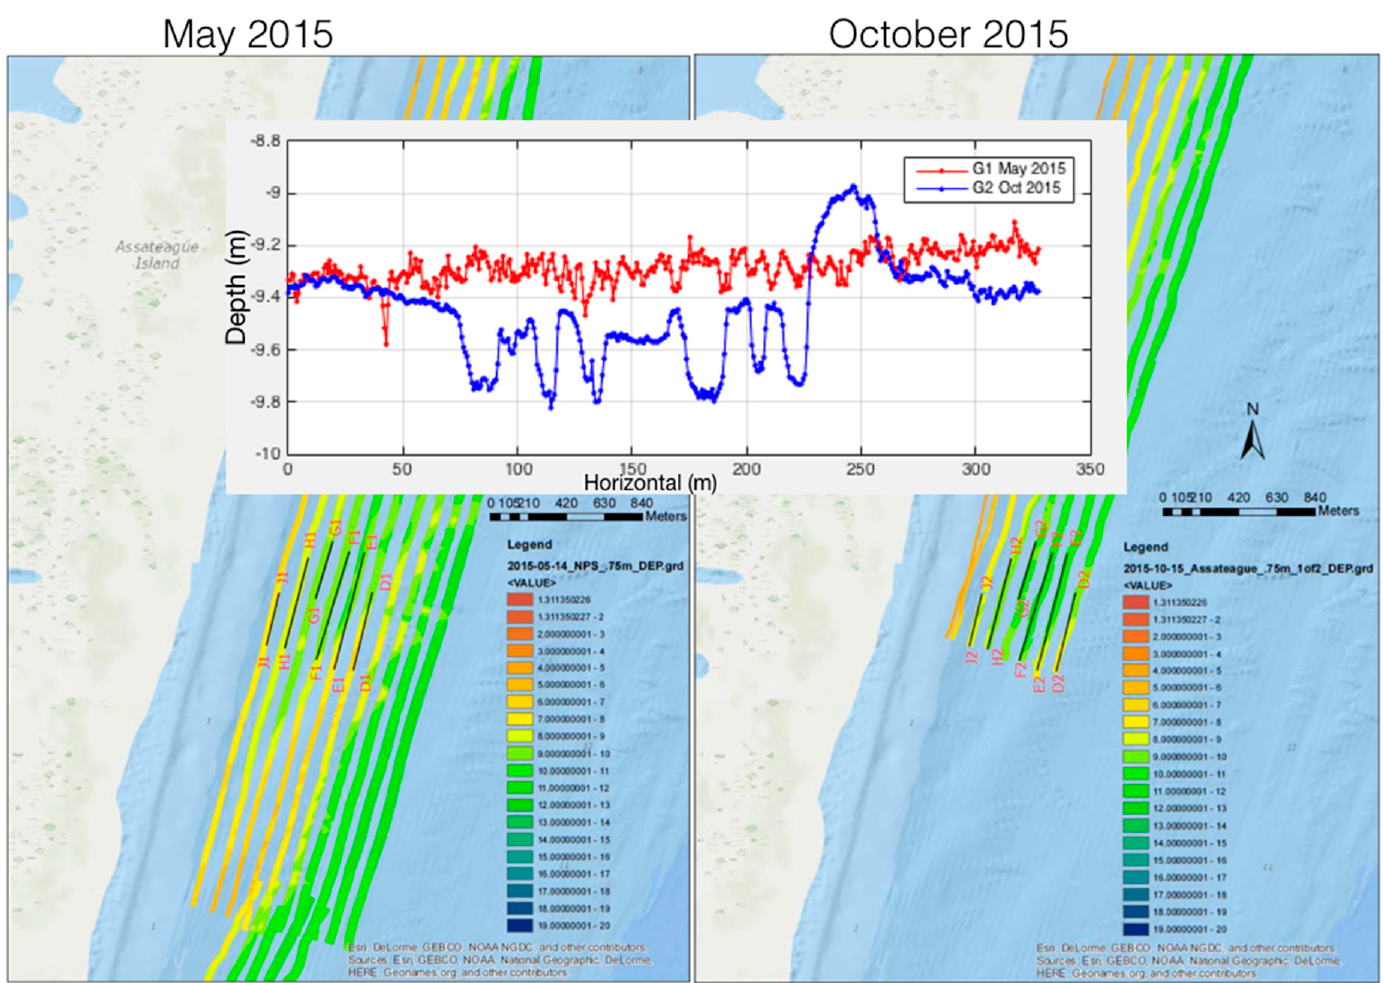
Figure 22. Bathymetry profile change after Hurricane Joaquin, Assateague Island National Seashore, Maryland. Red curved line represents the bathymetry profile C1 in May 2015 and blue curved line represents the bathymetry profile C2 in October 2015. Please note the Southwestward lateral shift of sand bars in the bathymetry profile. Inset scale is in meters on both axes.